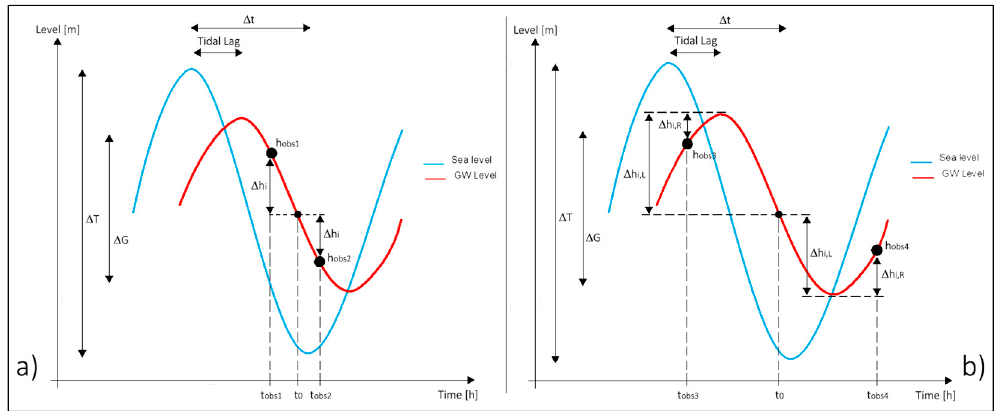
Figure 6. Groundwater level correction: Cases (i.) and (ii.) ( a ); and Cases (iii.) and (iv.) ( b ).